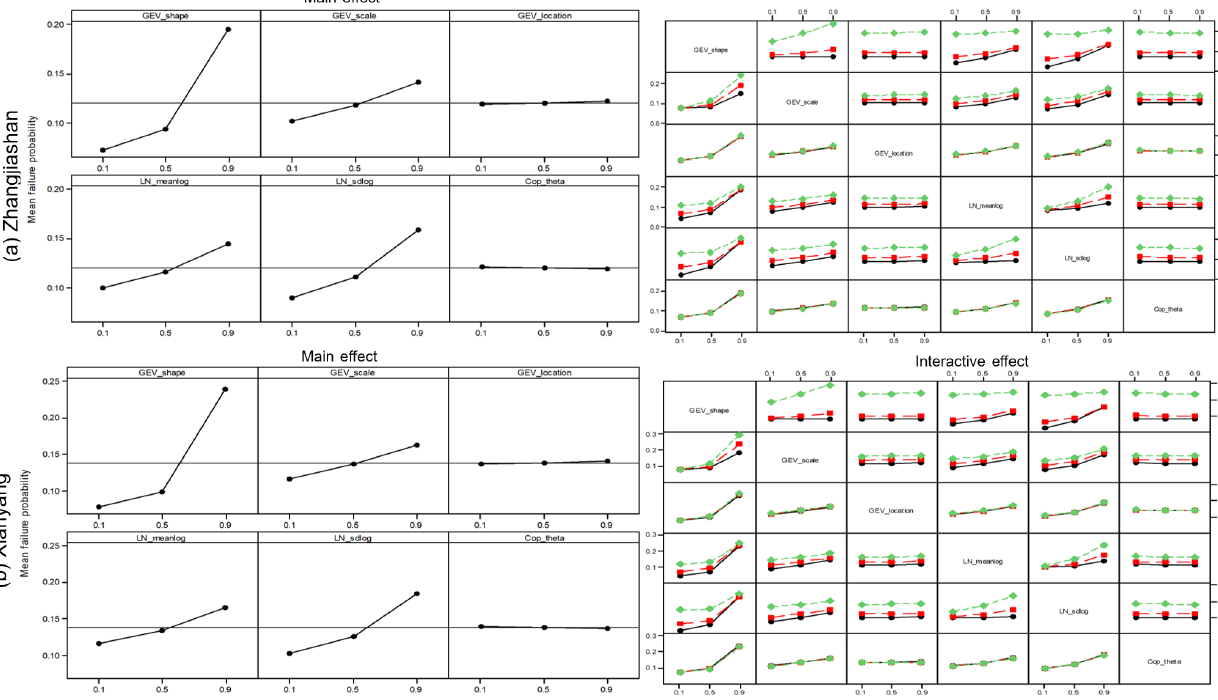
Figure 8. Main effects plot and full interactions plot matrix for parameters on the failure probability in OR at the two gauge stations.